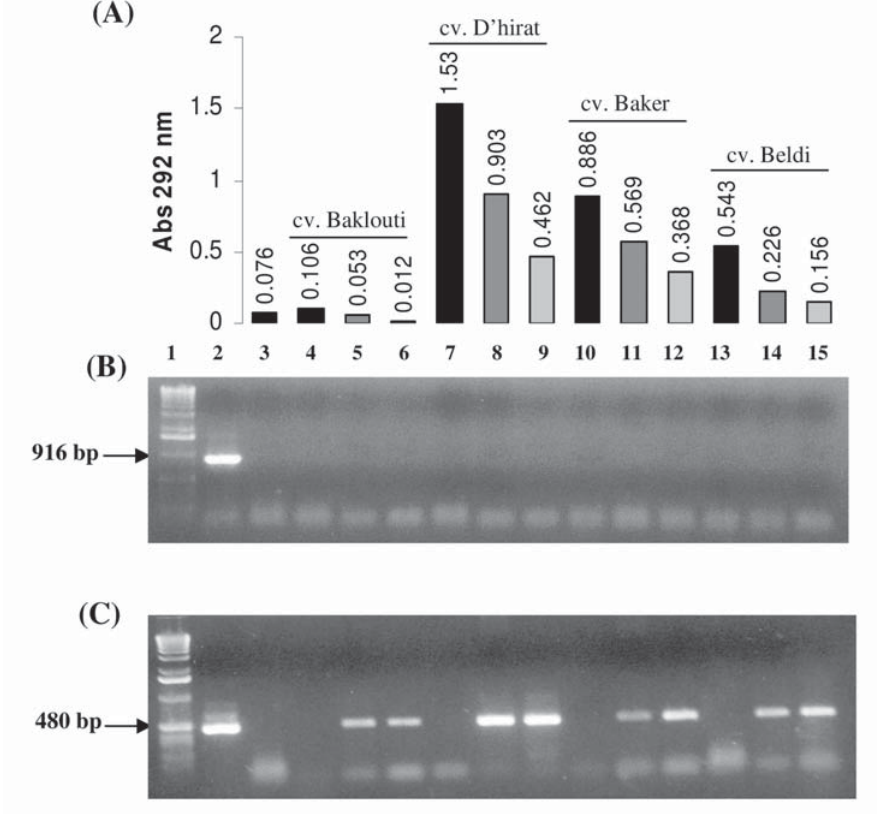
Fig. 1. Detection of PVY in pepper leaves by indirect ELISA-RT-PCR-nested PCR. Panel A, indirect ELISA absorb- ance values. Panel B, agarose gel electrophoretic analysis after indirect ELISA-RT-PCR. Panel C, agarose gel elec- trophoretic analysis after nested PCR. Each number indicates the same sample at each stage. Lane 1, 1 kb marker (Gibco-BRL). Lane 2, PCR positive control (the pCR ® 2.1 vector with capsid sequence, as input). Lane 3, PCR nega- tive control (tobacco leaf extract from healthy plant). Lane 4, crude leaf extract from pepper cv. Baklouti. Lanes 5 and 6, 1/5 and 1/10 (v:w) dilutions respectively of leaf sap from pepper cv. Baklouti. Lane 7, crude leaf extract from pepper cv. D’hirat. Lanes 8 and 9, 1/5 and 1/10 (v:w) dilutions respectively of leaf sap from pepper cv. D’hirat. Lane 10, crude leaf extract from pepper cv. Baker. Lanes 11 and 12, 1/5 and 1/10 (v:w) dilutions respectively of leaf sap from pepper cv. Baker. Lane 13, crude leaf extract from pepper cv. Beldi. Lanes 14 and 15, 1/5 and 1/10 (v:w) dilu- tions respectively of leaf sap from pepper cv.